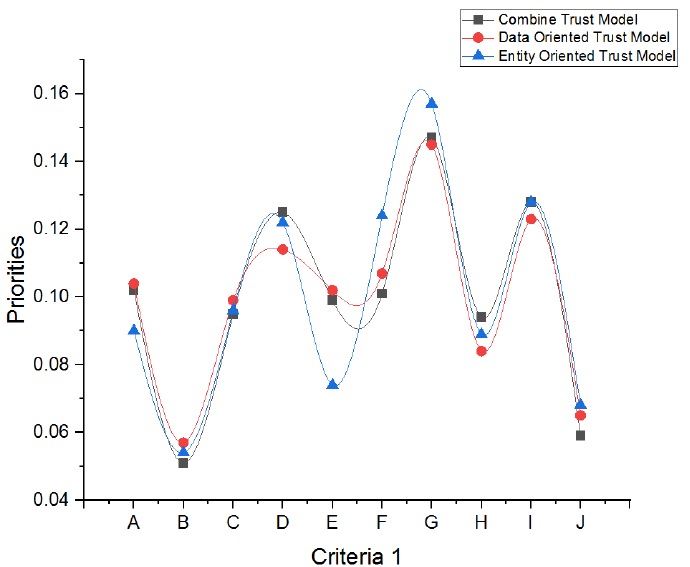
Figure 8. The Criteria 1 Influence on Alternatives.